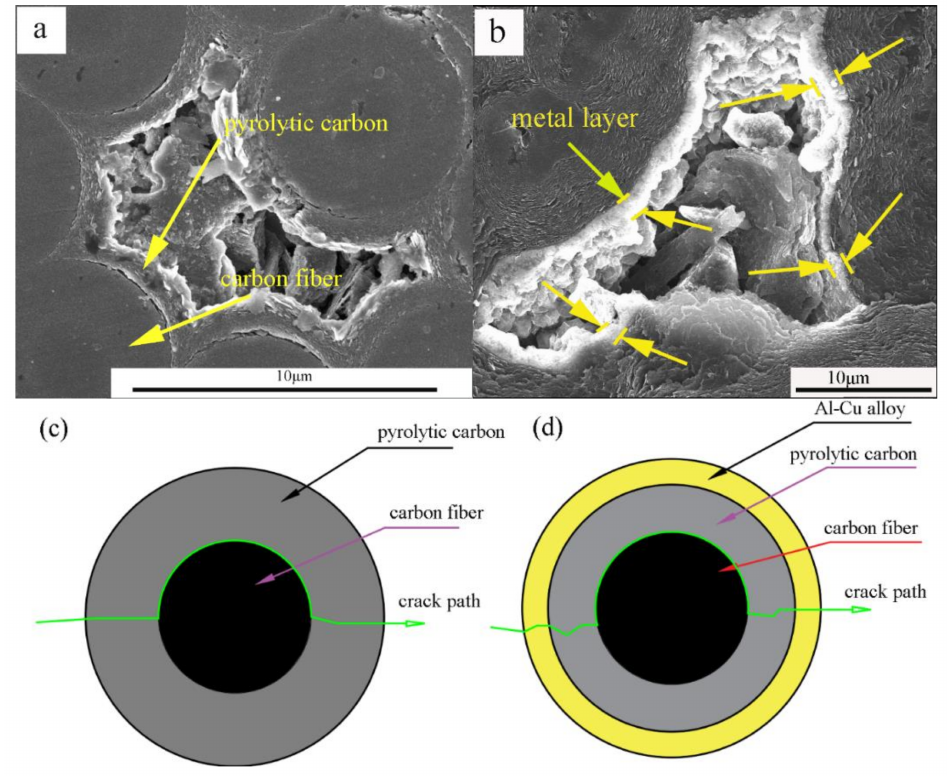
Figure 4. SEM micrographs of composite materials and Fracture mechanism model. ( a ) The microstructure morphology of C/C; ( b ) the microstructure morphology of C/C–Al–Cu; ( c ) the fracture mechanism diagram of C/C; and ( d ) the fracture mechanism diagram of C/C–Al–Cu.